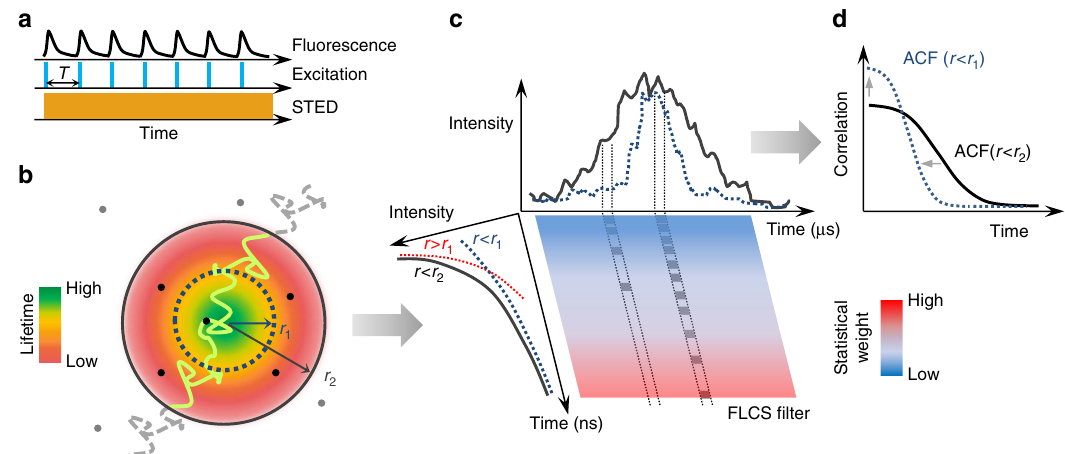
Fig. 1 Schematic principle of the SPLIT-FLCS method. a A pulsed laser excitation source is coupled with a CW-STED beam to exploit the variations in the fl uorescence dynamics observed in the nanosecond time scale ( t < T ). b The spatial variations of fl uorescence lifetime within the effective observation volume of the microscope can be modeled as a gradient in the radial direction, with the lifetime value being the highest at the center and decreasing towards the periphery. A molecule transiting within the observation volume will emit photons with different fl uorescence lifetime according to the radial position. c The temporal fi ngerprints associated to different spatial positions can be used to weight the photons based on their time of arrival in the nanosecond time scale. For instance, the decay associated to the region de fi ned by radial position r < r 1 can be used to generate a statistical fi lter that, by over-weighting the late-arriving photons, sort out only the intensity emitted from a smaller effective observation volume. d Correlation of the weighted photons on the time scale relevant for molecular diffusion ( t > 1 μ s >> T ) results in a fi ltered ACF associated to fl uctuations on a smaller effective observation volume, namely an ACF which is narrower and has larger